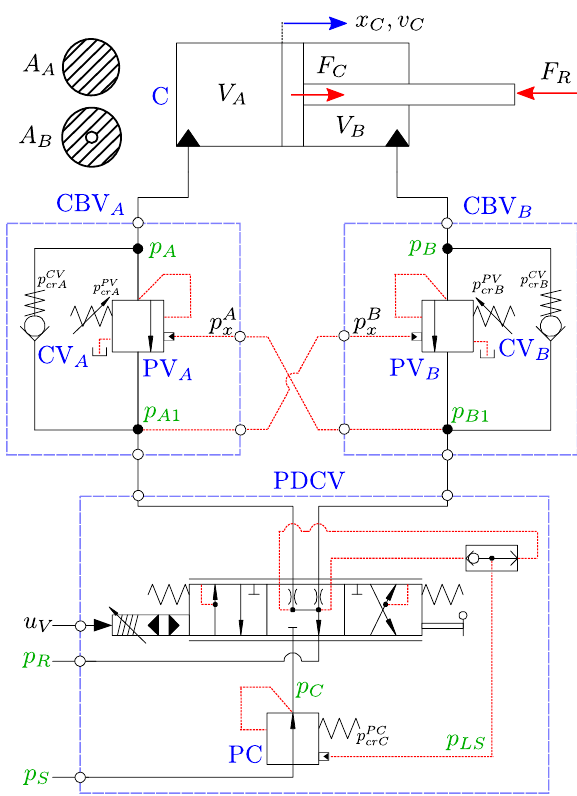
Figure 10: Valve-controlled cylinder architecture.